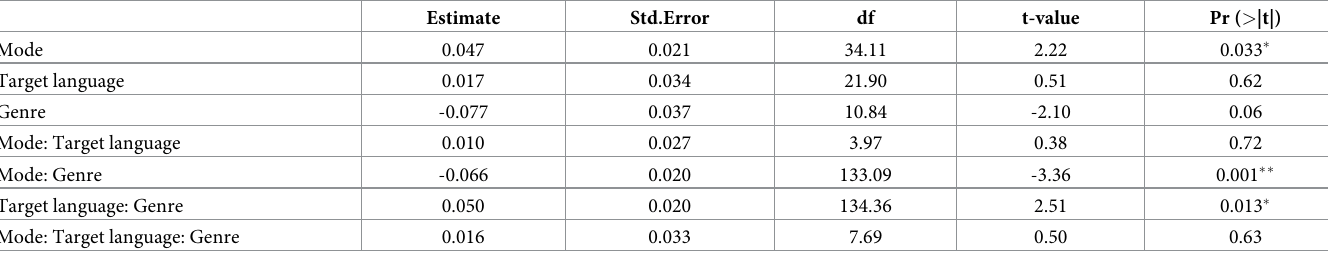
Table 5. Model results for average fixation count in